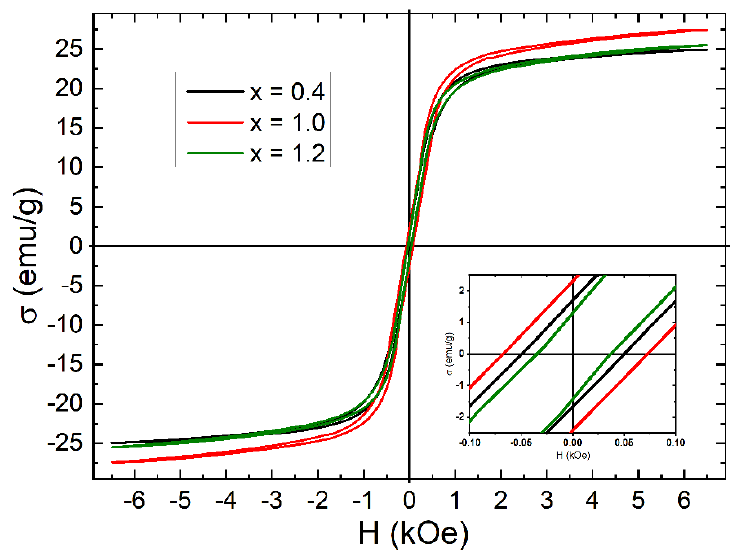
Figure 3. Hysteresis loops of hexaferrites Ni 2-x Cu x -Y system with x = 0.4, 1.0, 1.2 at room temperature. Table 3. The magnetic characteristics of the hysteresis loops of the hexaferrites Ni 2-x Cu x -Y system. Concentration, x Y-Phase, % σ S , emu/g σ r , emu/g